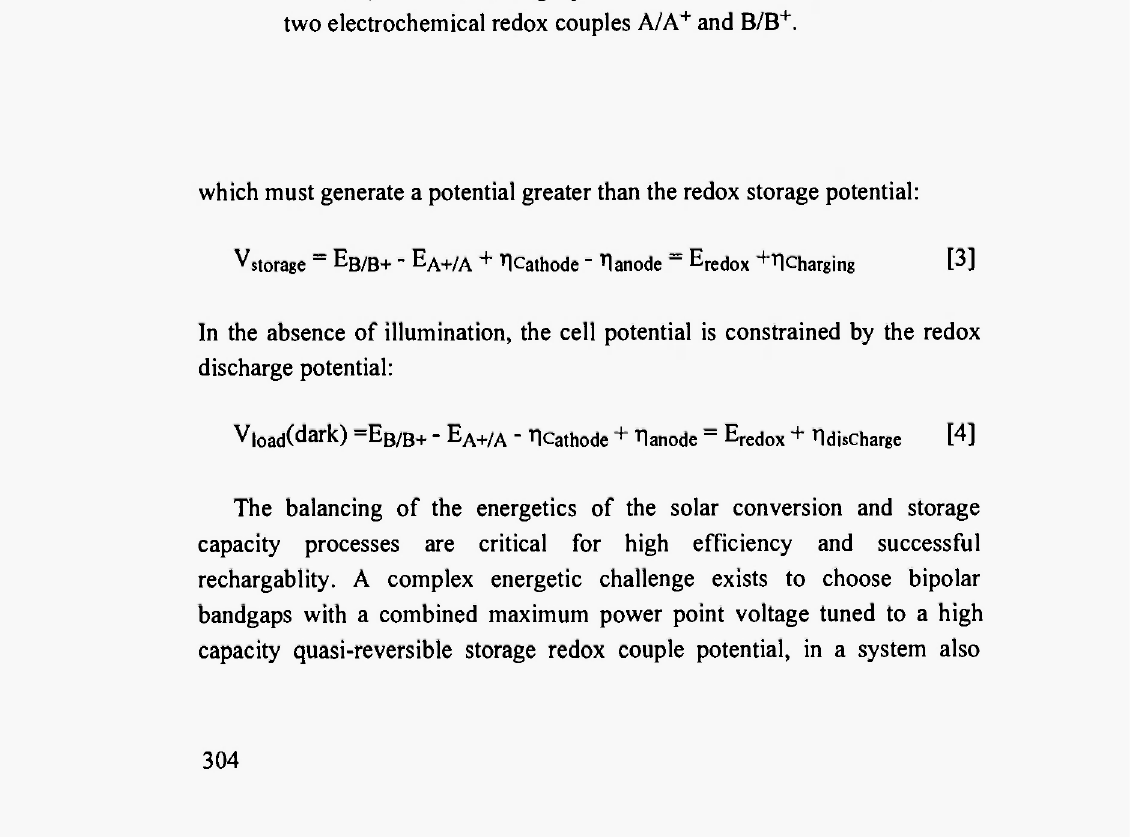
Fig. 1 : Energy diagrams for bipolar multiple bandgap indirect ohmic storage MBPEC; note that storage potential is the difference between the two electrochemical redox couples A/A + and B/B +